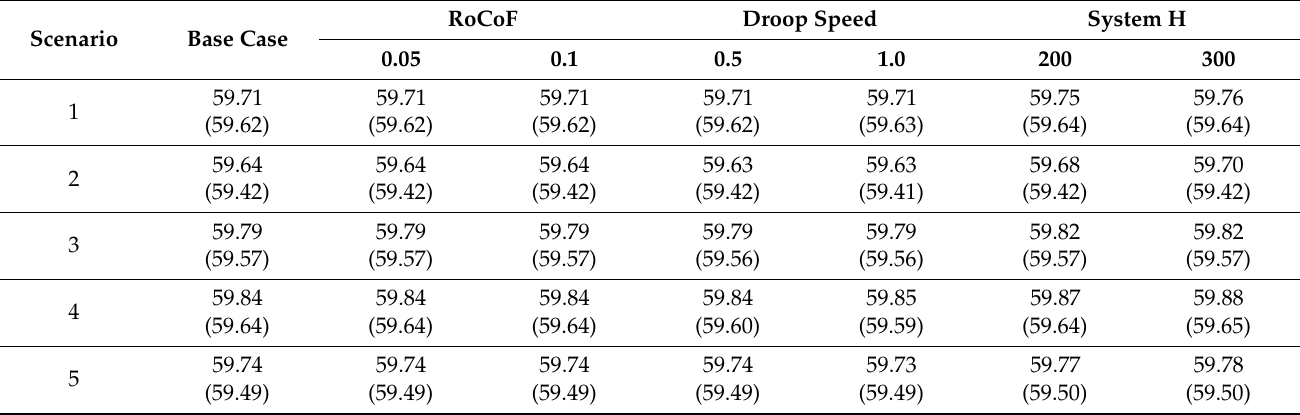
Figure 10. Frequency response by the ESS parameter (droop control). Table 8. Lowest frequency per parameter (RoCoF Control) (Hz): three-phase short